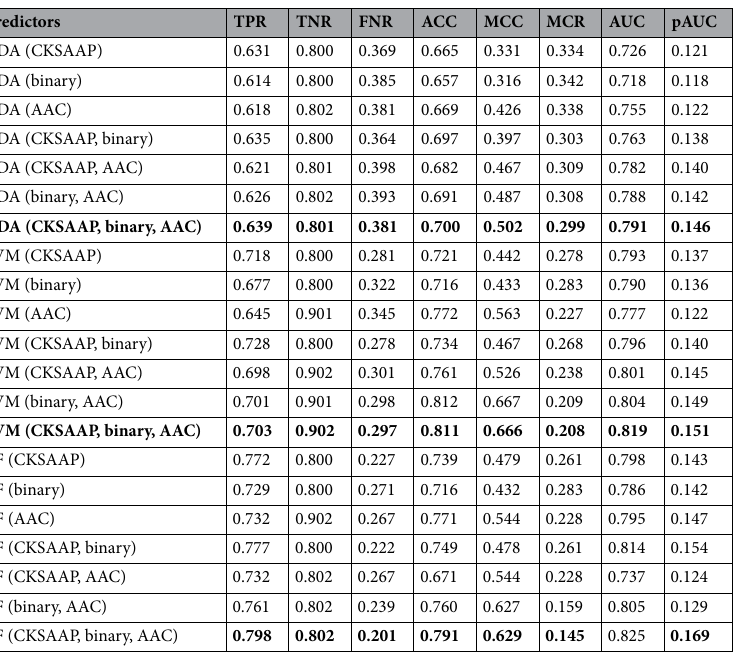
Table 3. Independent test performance scores at FPR = 0.20 for 21 prediction models that were trained by 1:2 ratio of positive and negative samples. Better results with each of ADA, SVM and RF were highlighted by bold